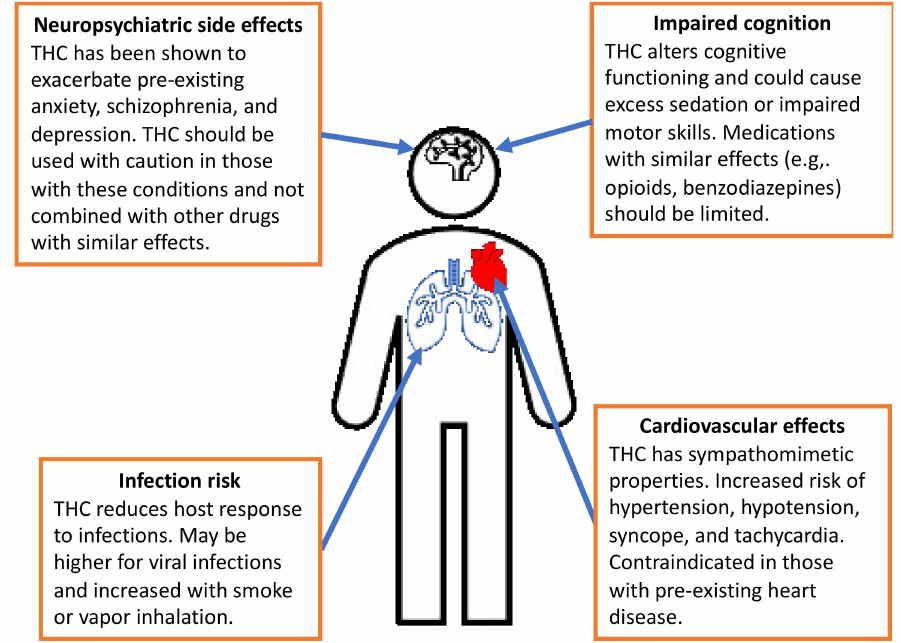
Figure 3. Representation of main adverse e ff ects of tetrahydrocannabinol use that can be potentiated by other